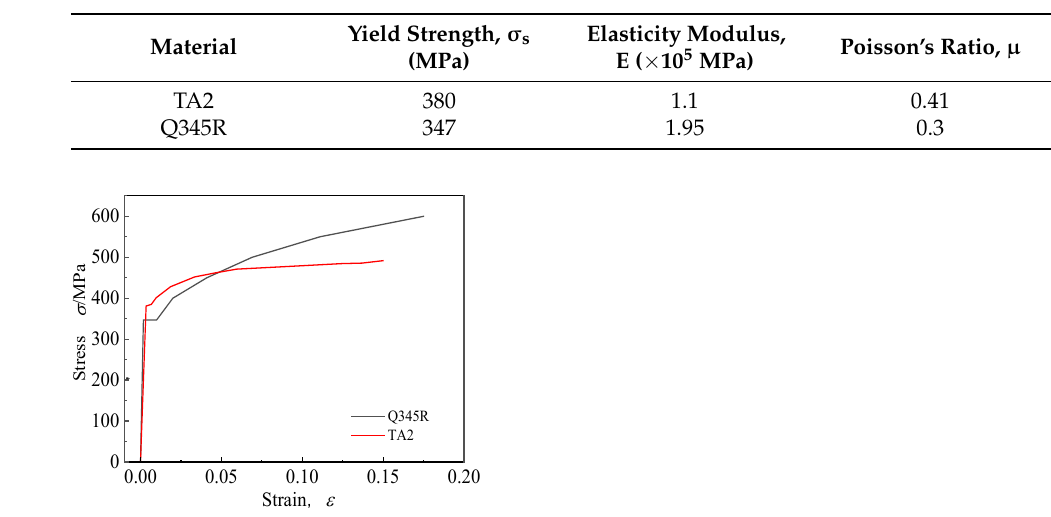
Figure 1. Tensile property curves of materials.